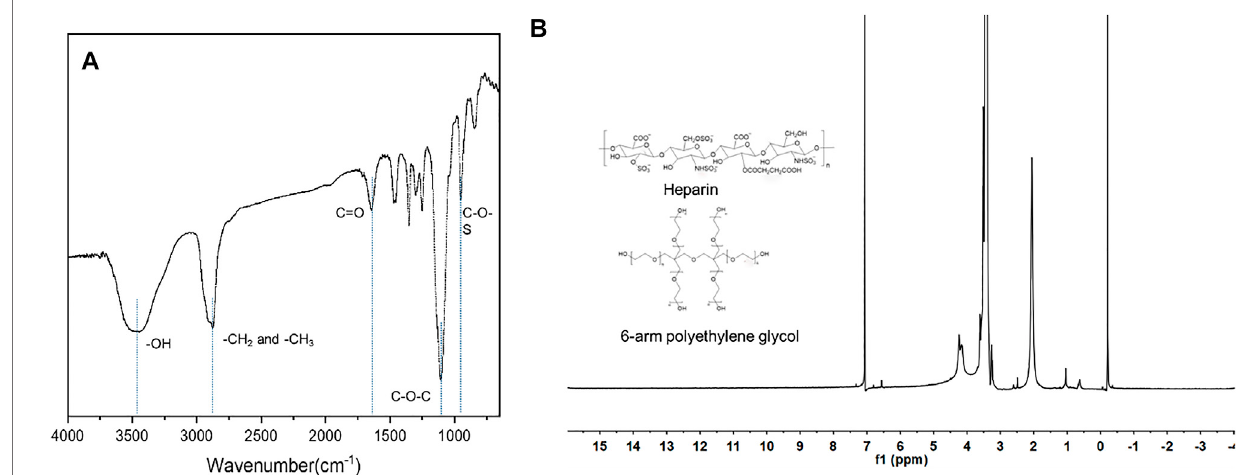
FIGURE 1 | The ATR-FTIR (A) and 1 H-NMR (B) of PEG-Hep.